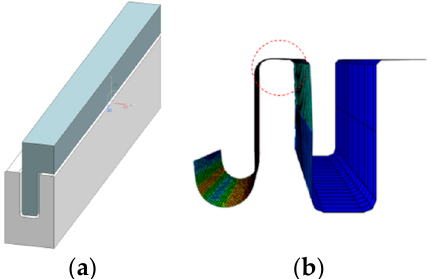
Figure 10. Modified punch for compressing rib: ( a ) punch shape and( b ) simulation result of formed rib.